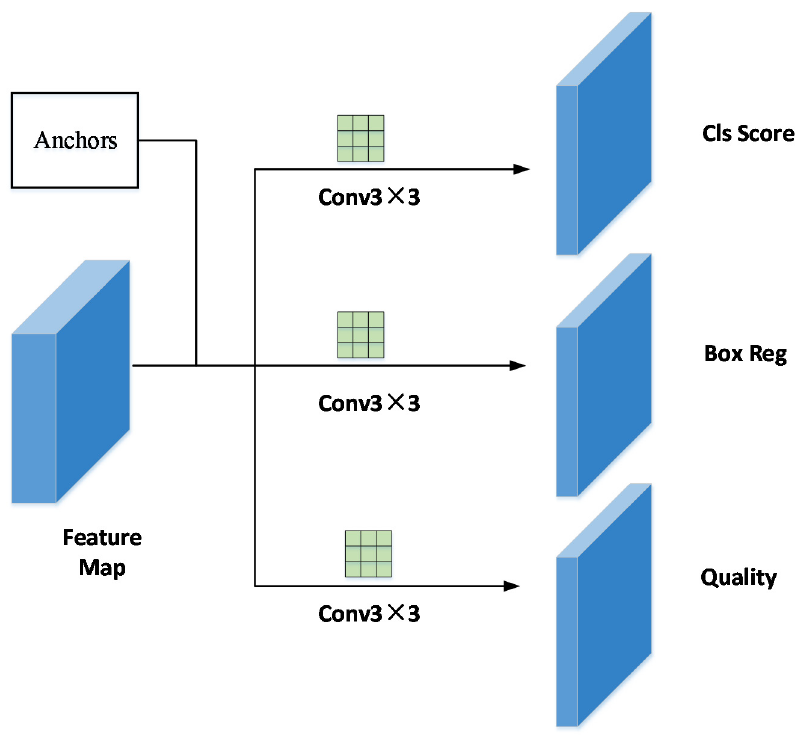
Figure 5. The structure of the head. The decoupling prediction structure is composed of three con- volution branches. convolution